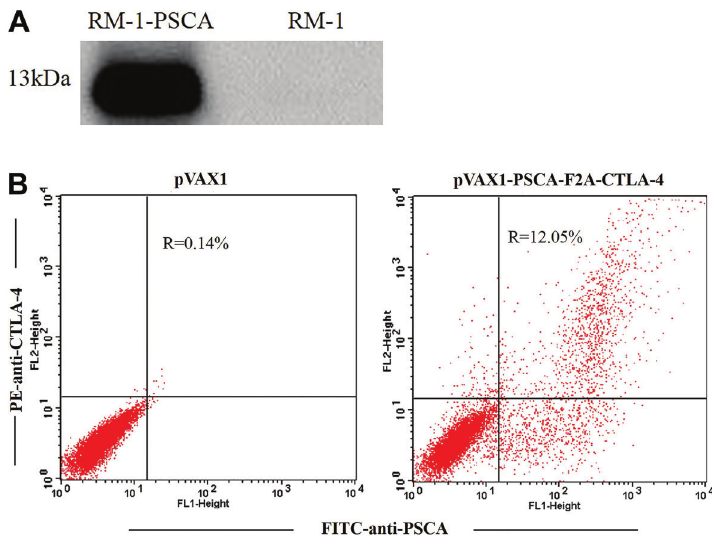
Figure 1. Expression of prostate stem cell antigen (PSCA) in RM-1-PSCA cells and fusion DNA vaccine in 293Tcells by western blot ( A ). Left , lysates of RM-1 cells stably transfected with pcDNA3.1-PSCA; Right , lysates of non-transfected RM-1 cells. B , expression of plasmid pVAX1-PSCA-F2A-CTLA-4 was studied by fl ow cytometry. Left , 293T cells transfected with pVAX1; Right , 293T cells transfected with pVAX1-